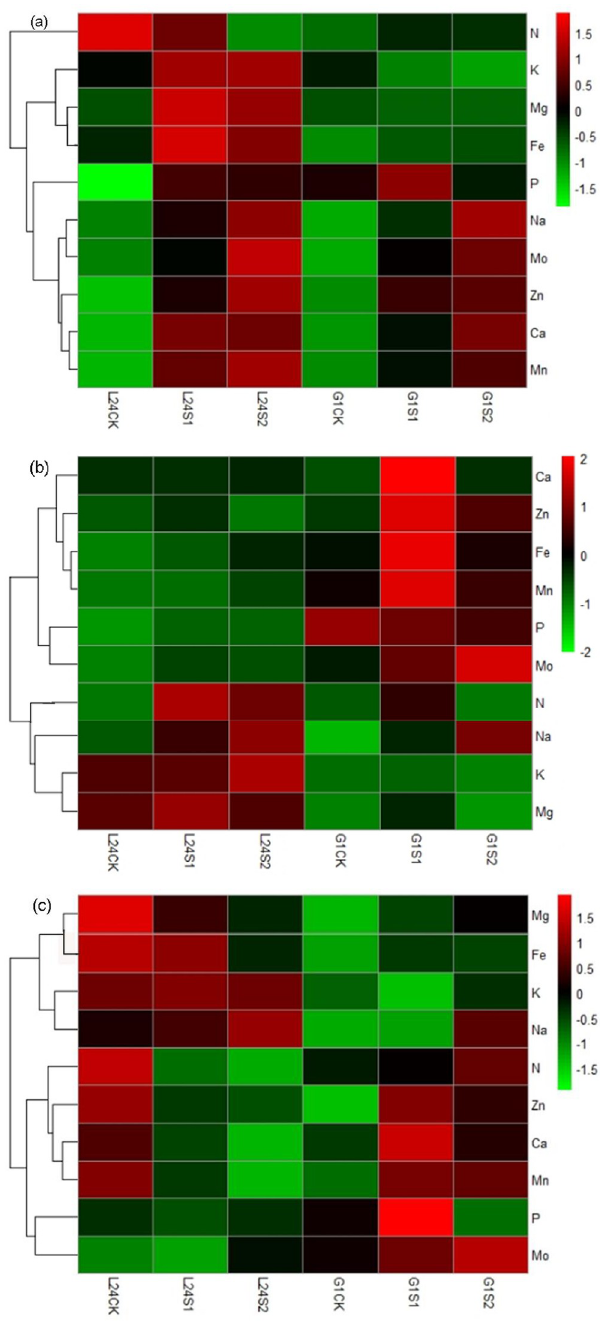
Fig 2. Hierarchical cluster analysis of element concentrations in leaves (a), stem (b), and root (c) of two cotton varieties (salt-tolerant variety L24, salt-sensitive variety G1) under saline stress (S1, S2). The abscissa represents the sample name, and the ordinate represents the elements. Different columns in the figure represent various samples, and rows represent element concentrations. The color represents the level of element concentrations in the sample.